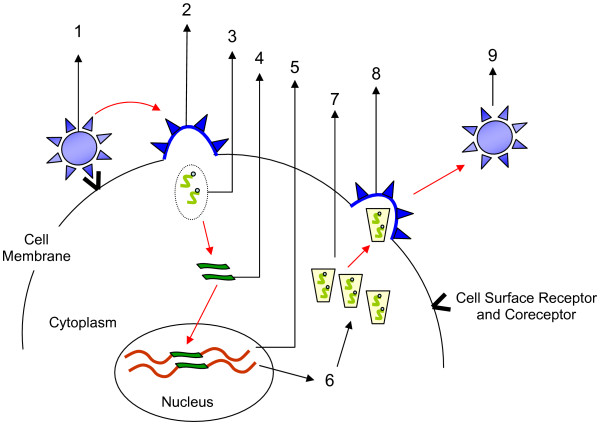
Schematic representation of the life cycle of HIV and the various steps at which anti- HIV gene therapy could be applied with key viral target proteins in parentheses: (1) HIV-1 attachment and binding (Env, gp120); (2) HIV-1 entry (Env, gp41); (3) Reverse transcription (reverse transcriptase and Vif); (4) Transport of HIV-1 DNA into the nucleus and integration with cellular DNA (Vpr, matrix, integrase). (5) Transcription of the HIV-1 proviral genome to produce both spliced and unspliced HIV-1 RNAs (Tat); (6) Transport of HIV-1 transcripts to cytoplasm (Rev); (7) HIV-1 gene expression and posttranslational modification of HIV-1 proteins (Gag, Gag-Pol, and Env polyproteins, Vif, and Nef). (8) HIV-1 virion assembly and morphogenesis within the cell (all virion proteins). (9) Release and maturation of the immature virion into a completely infectious particle (protease, Vpu, and Nef).